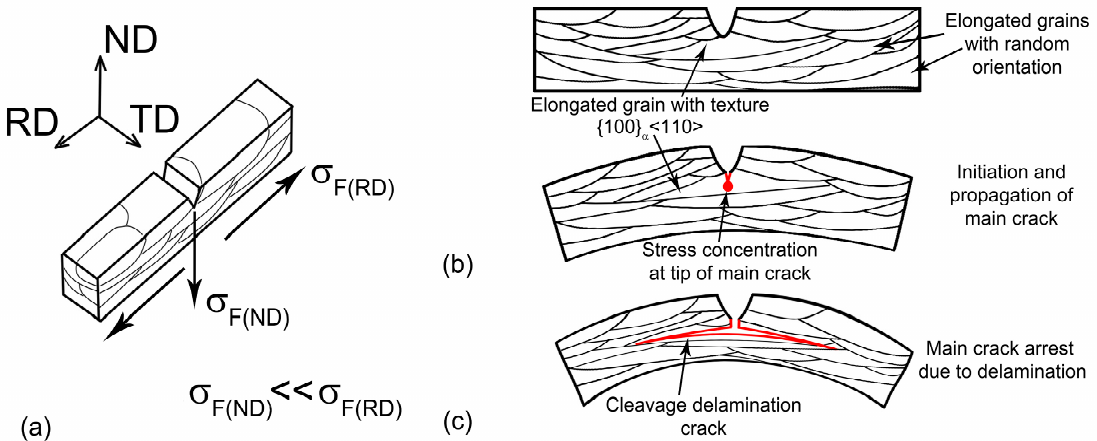
Figure 10. Schematic illustration of delamination in ND–Charpy V-Notch specimen after tempforming: ( a ) the effect of grain size on the fracture stress, ( b ) the nucleation and propagation of main crack at first stage of fracture, ( c ) formation of secondary crack in RD along lamellas with {100} α <110> orientation.